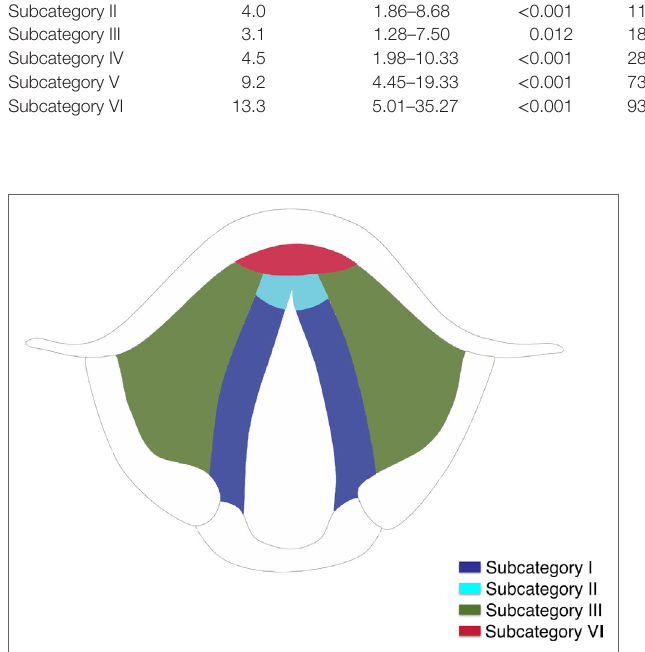
FigUre 4 | Three-dimensional map of the isoprognostic zones I, II, III, and VI, view from above.